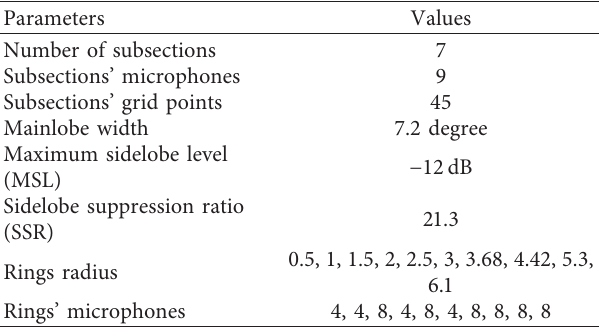
Figure 7: Three different irregular array configurations with the same microphone density and number: (a) log-spiral wheel array; (b) pizza array; (c) partition array. Table 2: Optimal parameters of partition